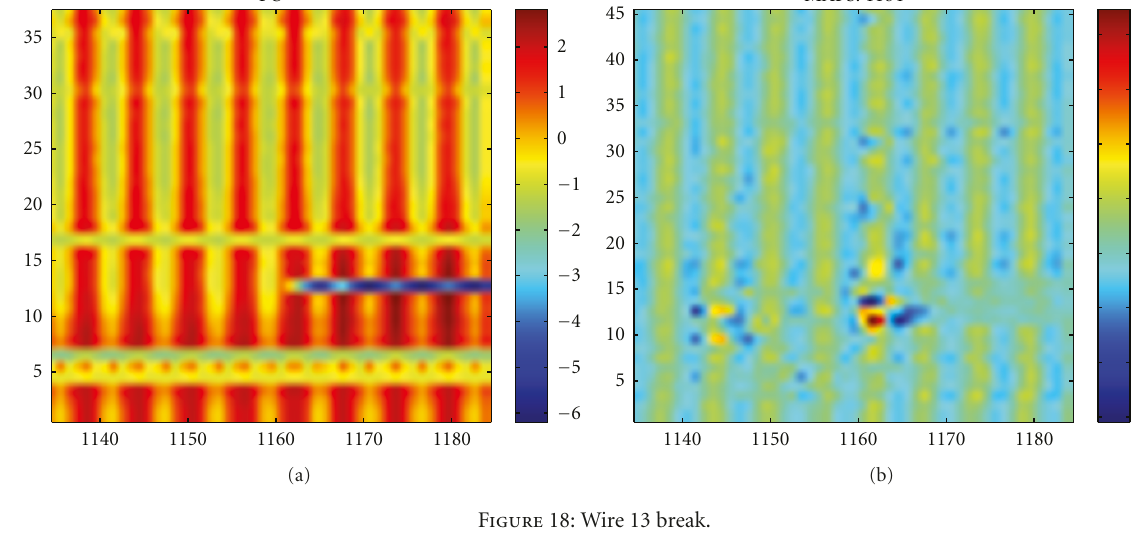
Figure 18: Wire 13 break.